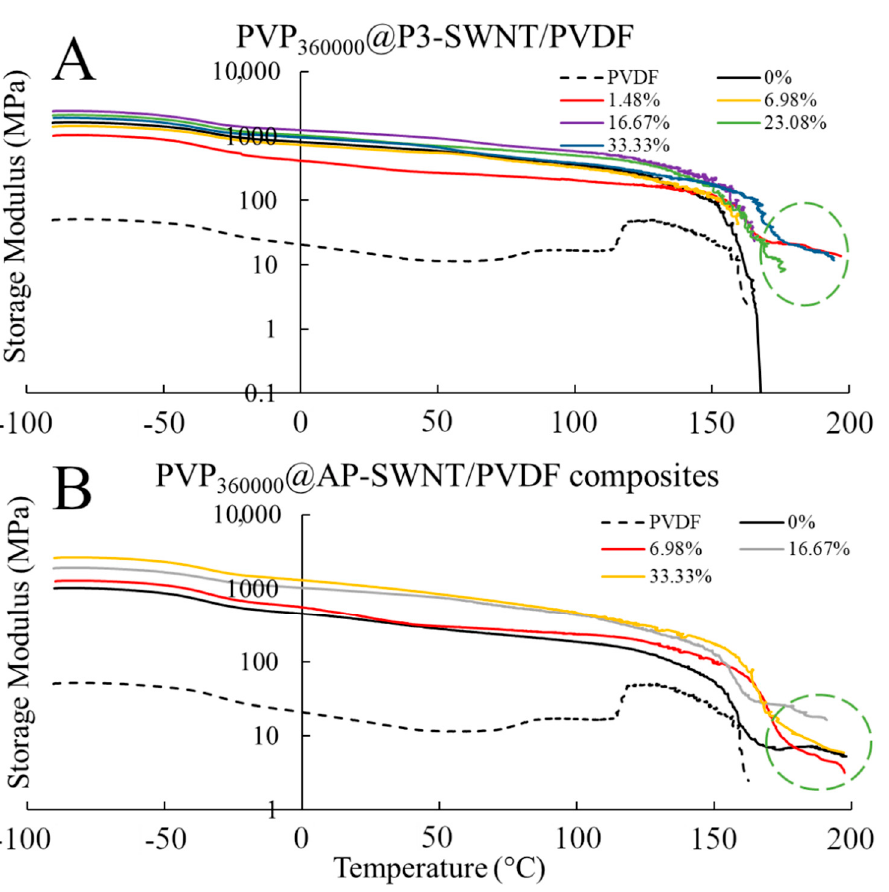
Figure 7. ( A ) Thermal conductivity of two different types of PVP 360000 functionalized CNT/PVDF composites; ( B ) Percent Crystallization; and ( C ) Electrical conductivity of PVP 360000 functionalized CNT/PVDF composites at different PVP concentrations.